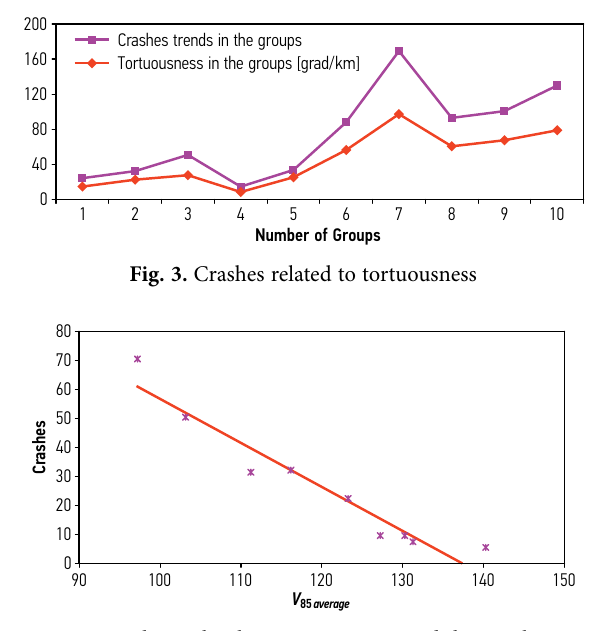
Fig. 4. Relationship between V 85 average and the number of crashes